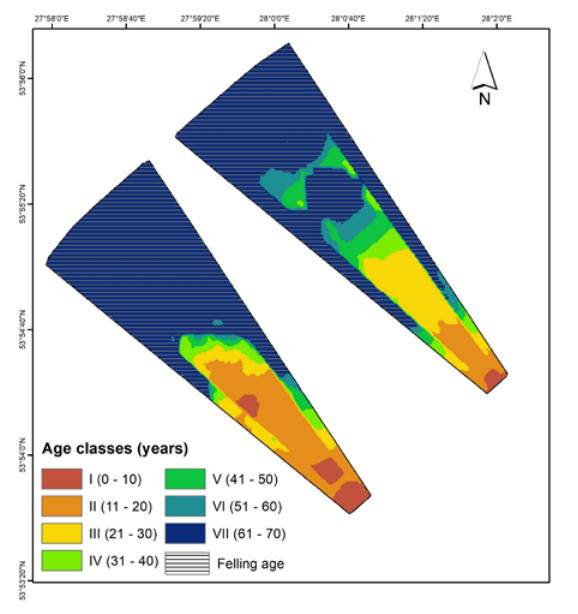
Figure 10. The birch forest age